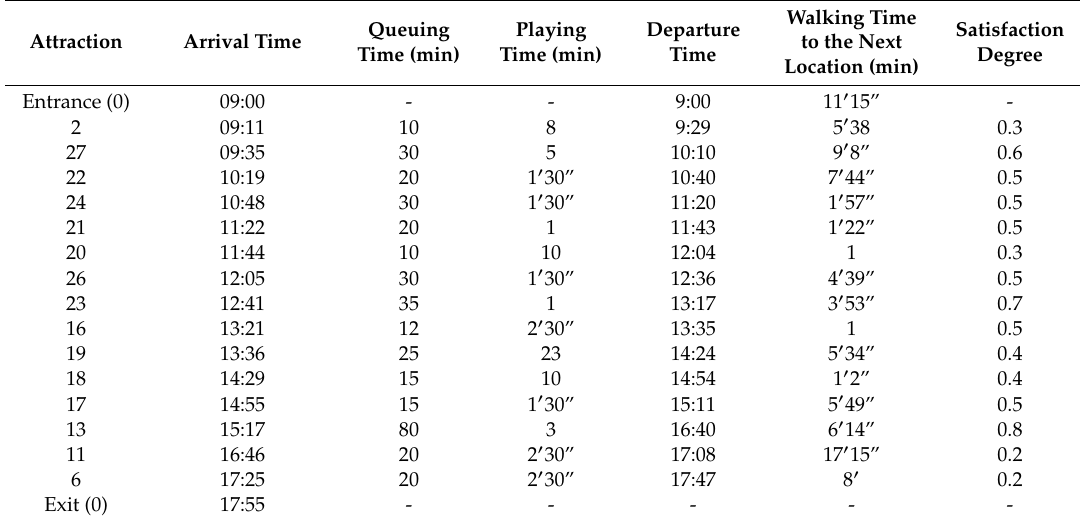
Table 4. Results of the satisfaction route with APGA (28 attractions).